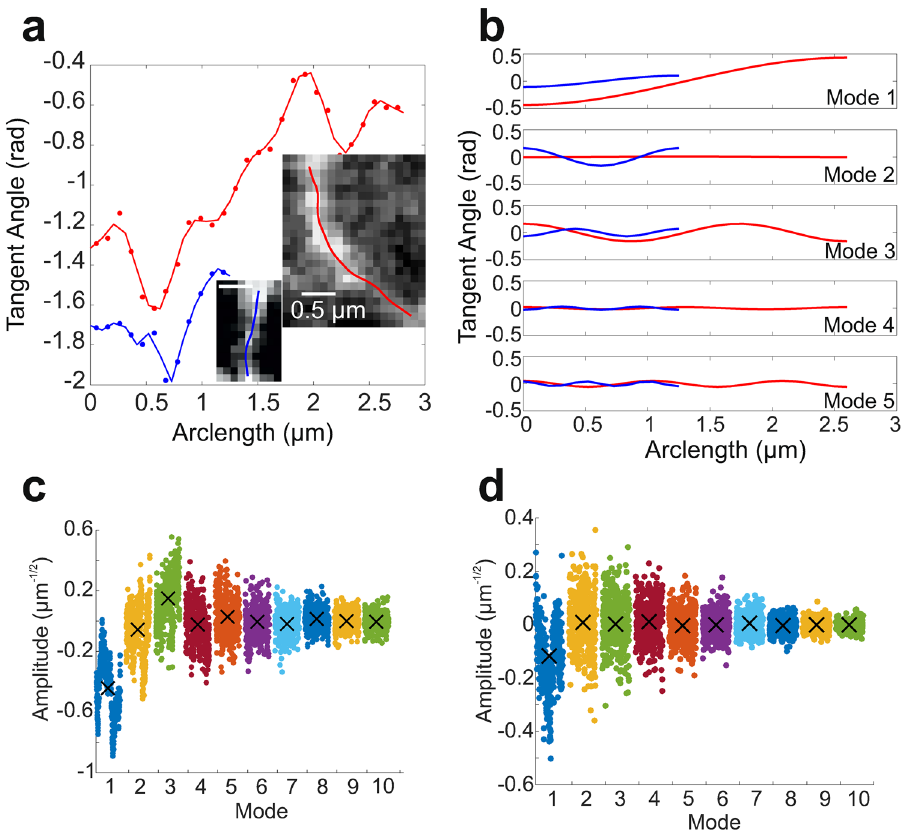
Figure 4. Tubule contours modelled with Fourier modes. ( a ) Tangent angles as a function of arclength, calculated directly from the tracked points (solid line) and from the modelled Fourier modes (points) for the tubules in the insets. ( b ) First 5 Fourier modes used to model the tubules in the single frame depicted in ( a ). ( c ) Mode amplitudes of the red tubule in ( a ) for each tracked frame. ( c ) Mode amplitudes of the blue tubule in ( a ) for each tracked frame. Black crosses show mean mode